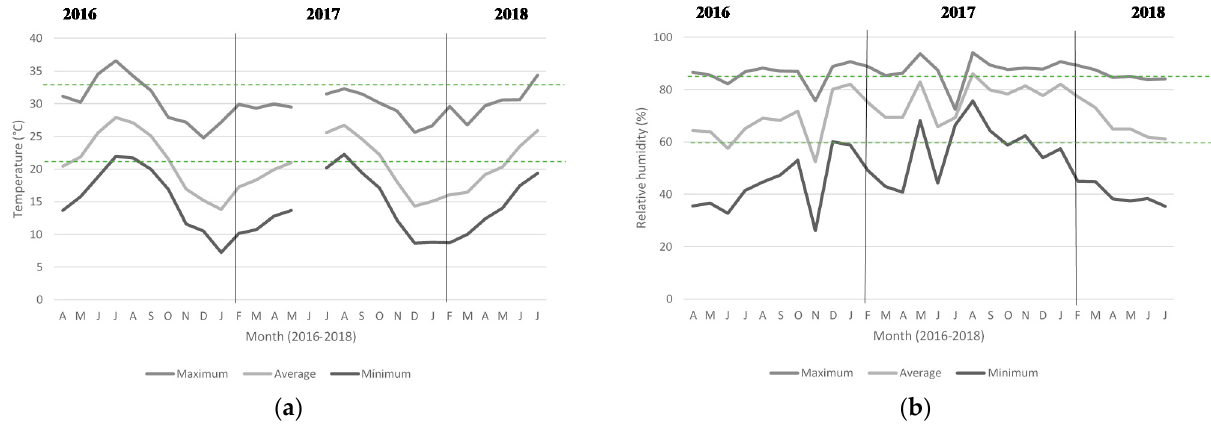
Figure 1. ( a ) Maximum, average, and minimum temperatures and ( b ) relative humidity calculated in the passive climate control module. The horizontal dotted lines mark the optimal temperature and relative humidity ranges for papaya crop, according to Nakasone and Paull (1998) [2] and Campostrini and Glenn (2007) [4].